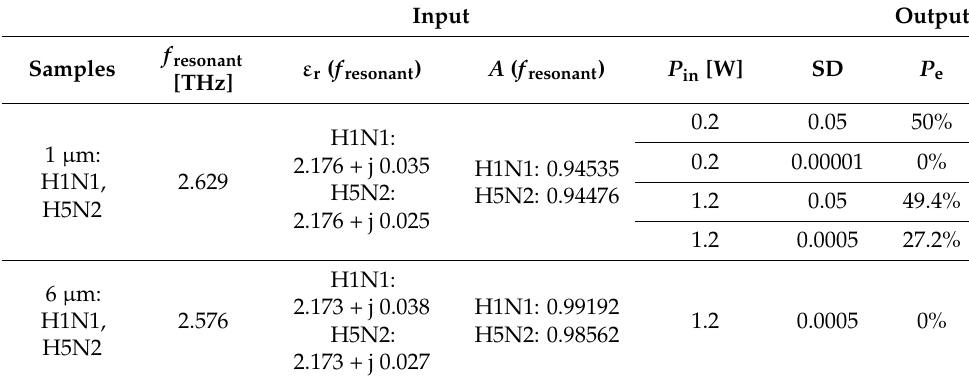
Table 7. Results of estimated error probability for different input